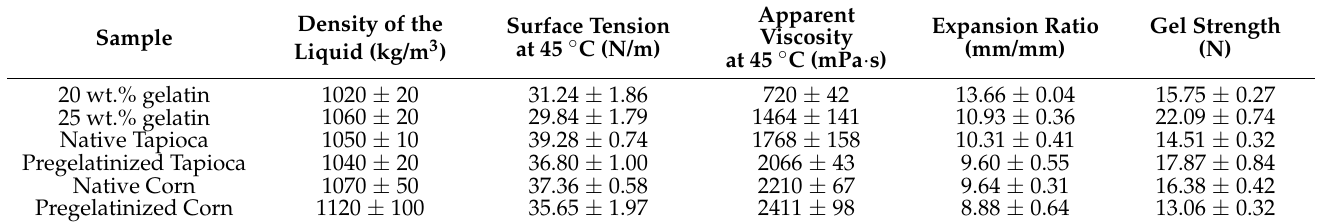
Table 4. Gelatin and gelatin–starch suspensions density, surface tension, apparent viscosity and expansion ratio at 45 ◦ C and gel